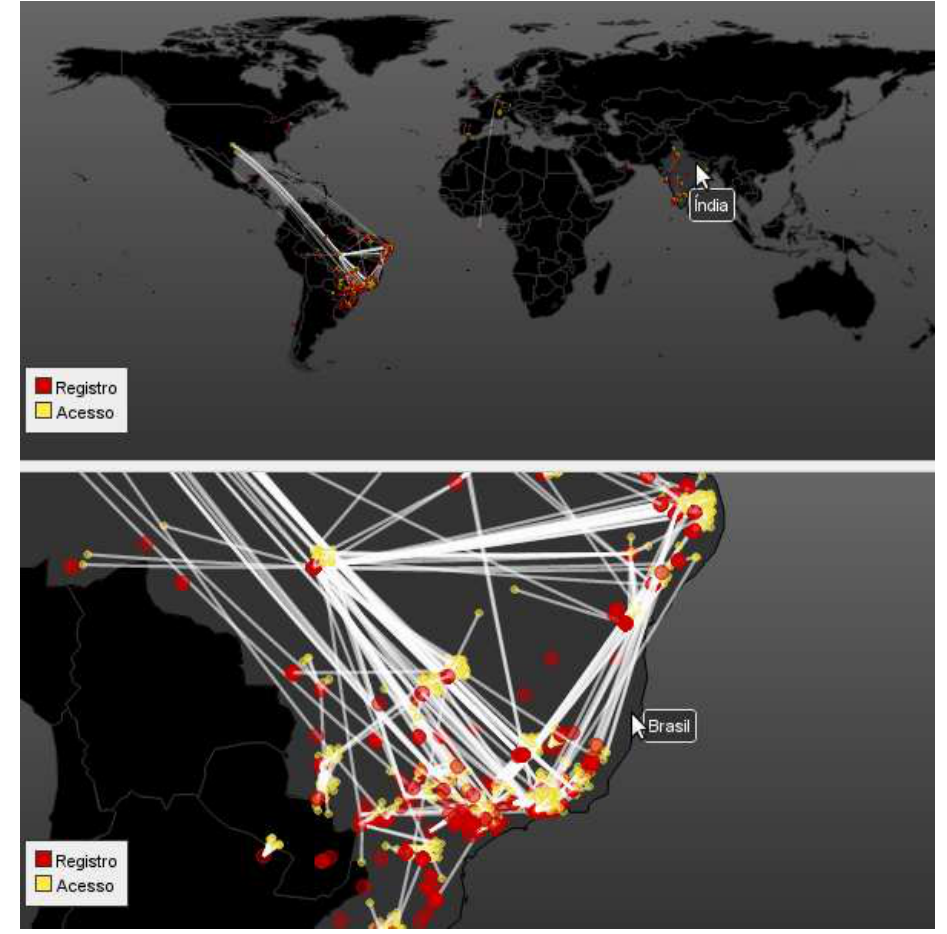
Fig. 12. Great circles used to represent data about Turko operation